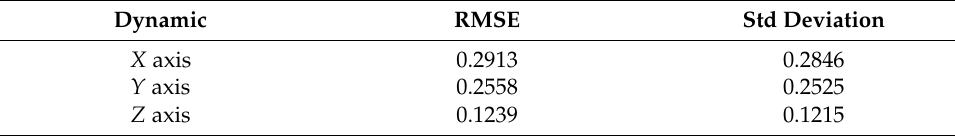
Table 6. Performance index comparison for 3D helical